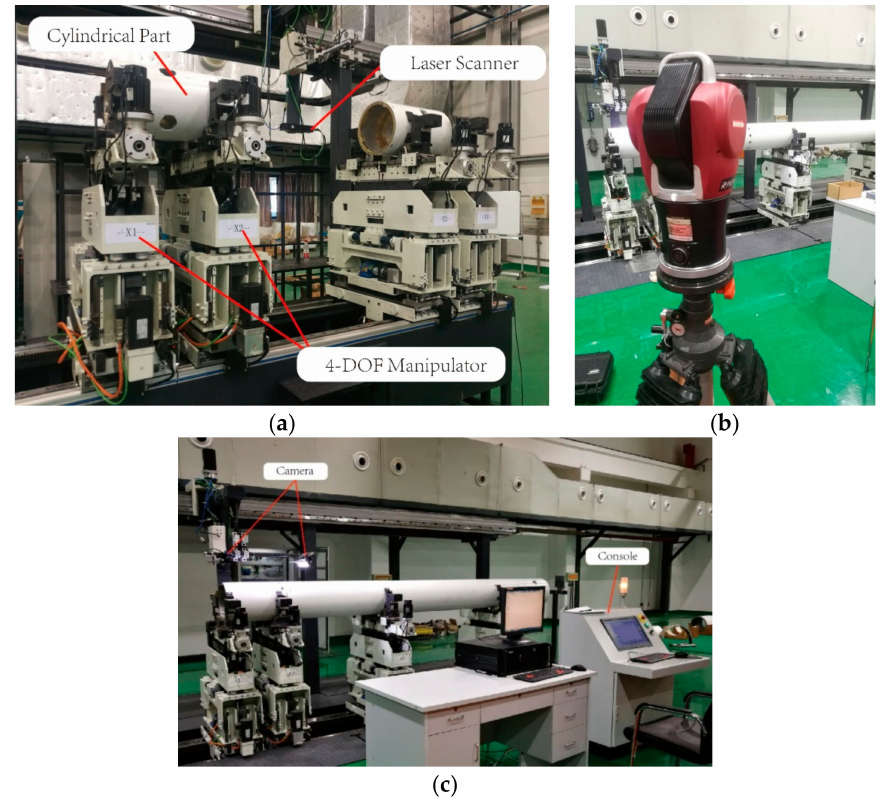
Figure 8. Prototype: ( a ) automatic assembly system; ( b ) laser tracker system(LTS); ( c ) prototype after an assembly processing.